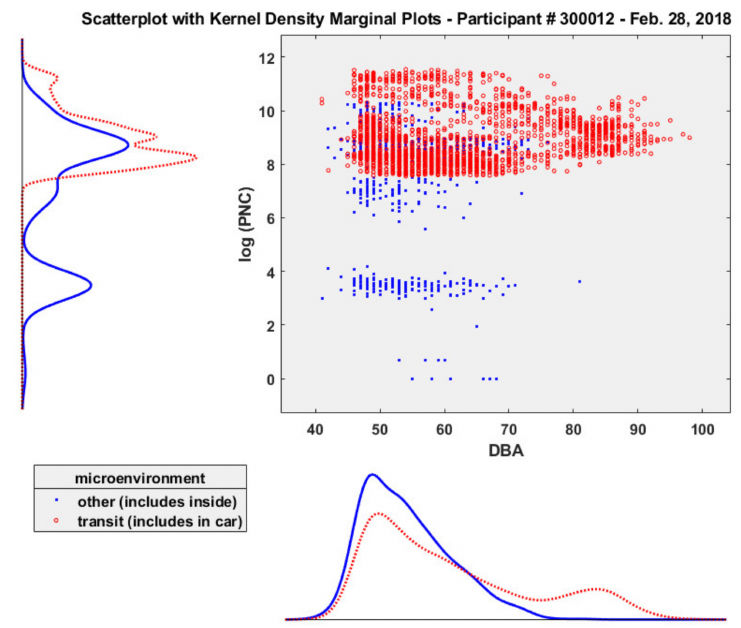
Figure 5. Scatter plot and kernel density plots of log PNC and noise, participant # 300012 (28 February